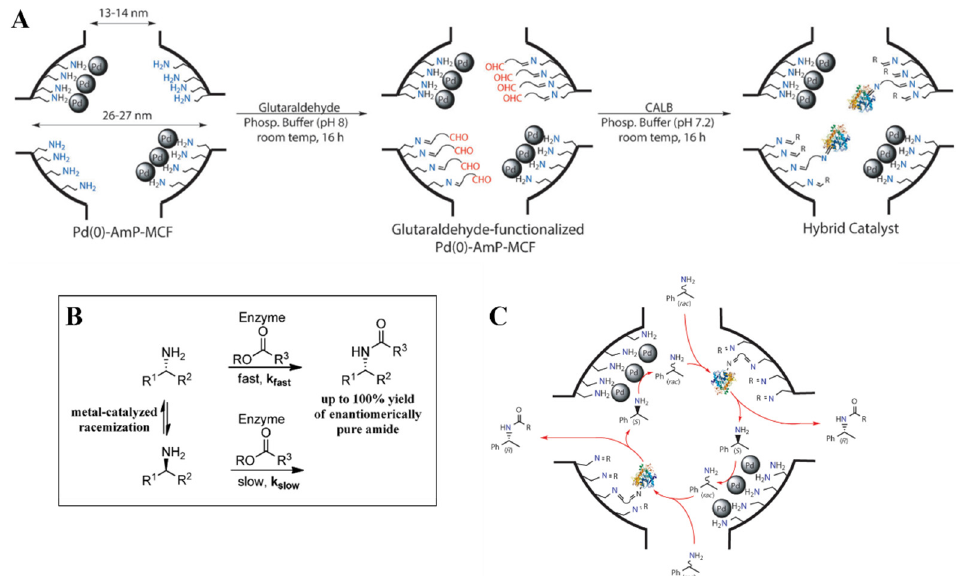
Figure 26. ( A ): Synthesis of the bi-functional hybrid catalyst. ( B ): Schematic representation of a general dynamic kinetic resolution (DKR) of a primary amine. ( C ): DKR of an amine with a bi-functional biomimetic catalyst in which Pd nanoparticles and a lipase (CALB) are co-immobilized in the same pore of MCF. Reprinted with permission from [121]. Copyright 2012, John Wiley and Sons.